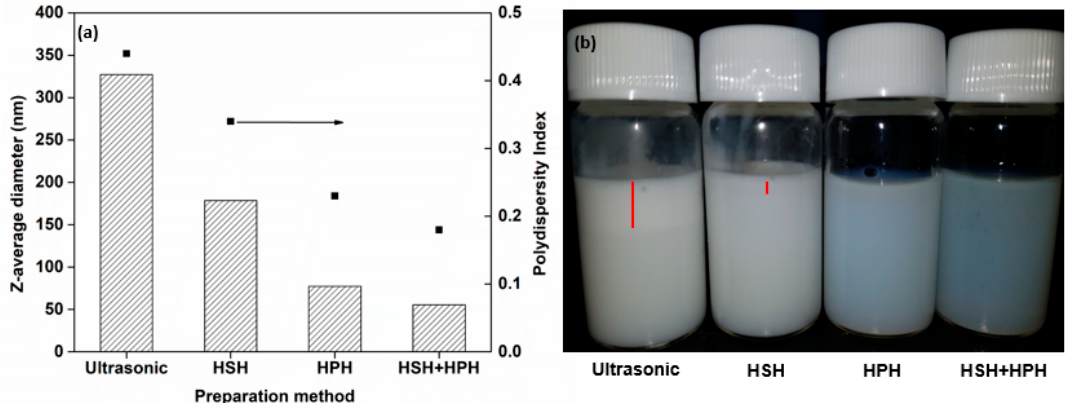
Figure 7. ( a ) Effect of nanoemulsion synthesis method on nanoemulsion size. ( b ) Images of the limonene nanoemulsion formed by various methods after 28 days. Red line indicates the cream thickness of the nanoemulsion.